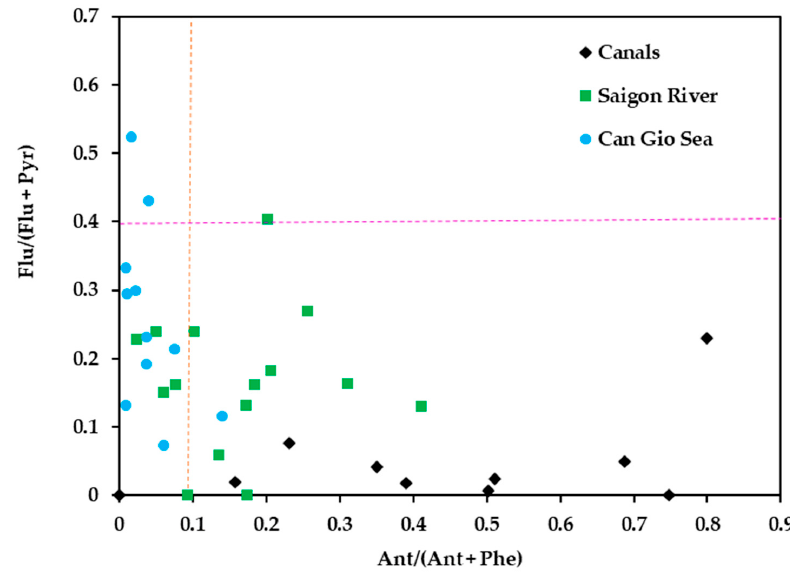
Figure 9. The bi-diagnostic ratios of Flu/(Flu + Pyr) and Ant/(Ant + Phe) in MPs found in Canals (black diamond), Saigon River (green square), and Can Gio sea (blue dot).